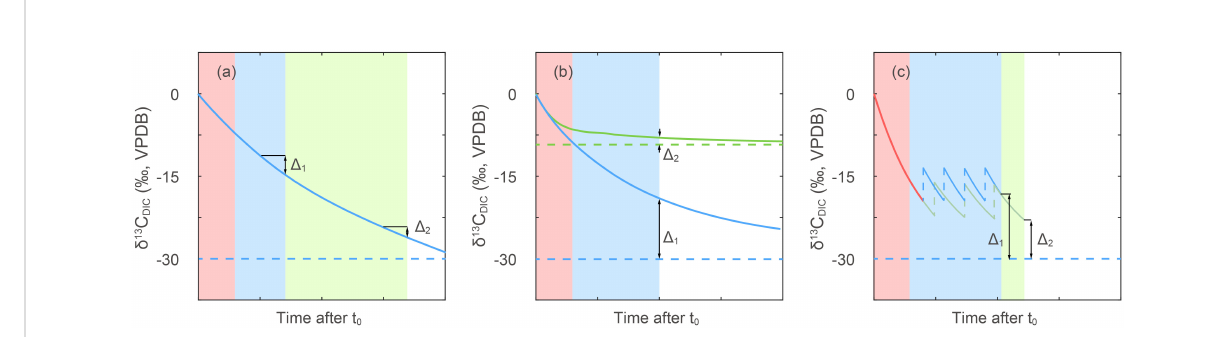
FIGURE 5 Concept model of isotopic disequilibrium effects in different experimental setups. Time advances from left to right in unspeci fi ed units since actual equilibration timescales depend on vessel dimensions and bubbling rate and surface area. Red shading areas represent the period in which media was bubbled before addition of cells. Blue and green shaded areas represent culture duration with bubbling. Horizontal dashed lines represent the d 13 C DIC after reaching equilibrium with CO 2 (g), while solid lines give the time varying d 13 C DIC for different scenarios detailed below. Blue lines are shown for the common situation of bubbling a media of initial d 13 C DIC close to surface seawater (~0 ‰ ) with CO 2 (g) of ~-38 ‰ . The D 1 and D 2 are used to illustrate potential errors in estimation of d 13 C DIC , as detailed below. (A) Potential effect of the timing of sampling on the uncertainty in the d 13 C DIC . Because cells are produced not only the last day, but also a period of time before harvest, if the d 13 C d 13 C DIC at time of cell harvest time was employed in fractionation calculation, the more rapid DIC evolution early in the experiment could lead to a larger error as ( D 1 vs D 2 ). Different CO 2 concentration treatments with different rates of reaching equilibrium, or different culture durations can cause differences in error as well as bias the estimation of d 13 C DIC corresponding to period of cell production. (B) Comparison of the effect of d 13 C CO2(g) of -38 ‰ (blue lines) vs ~-17 ‰ (green lines) on estimation of d 13 C DIC . The DIC carbon isotope would reach equilibrium faster with a CO 2 (g) to DIC isotopic difference of around -8.3 ‰ leading to a smaller disequilibrium. This effect could be more serious when the DIC carbon isotope ratios are not measured. (C) The effect of dilution frequency on DIC carbon isotope evolution in continuous culturing set- ups. Blue and green lines present two different dilution treatments and red line represents d 13 C DIC evolution before fi rst dilution. The vertical dashed lines represent positive shifts in carbon isotope caused by dilutions with un-bubbled seawater. Higher dilution rate would lead to a larger disequilibrium as D 1 , if the seawater reservoir is not pre-bubbled to equilibrium with CO 2 (g), which could also increase the error of fractionations in continuous culture